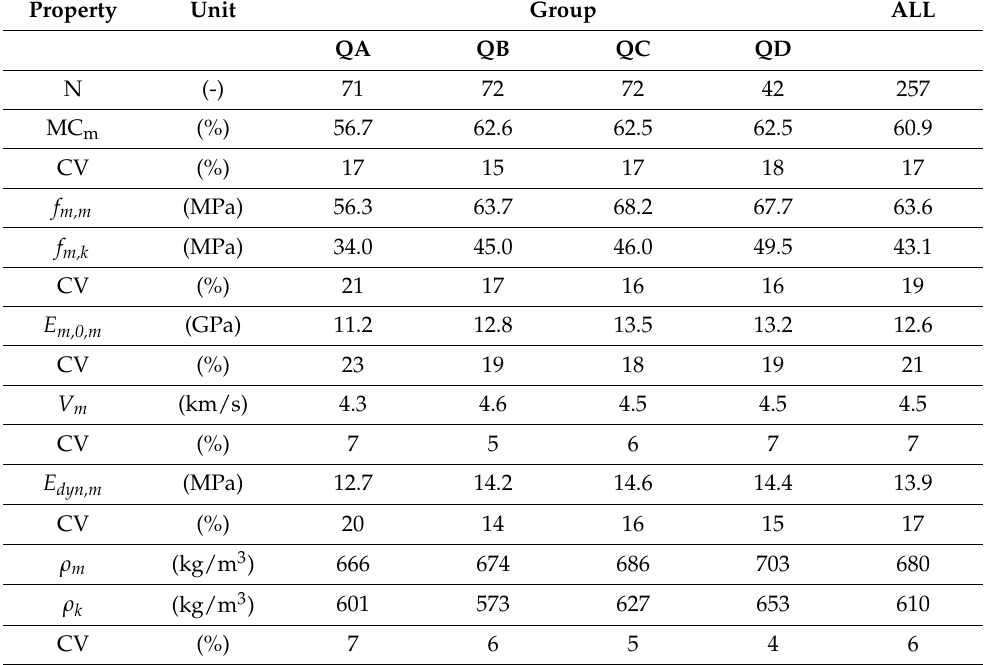
Table 1. Mean values and coefficients of variation (CV) of physical and mechanical properties for the 4 groups of round logs (QA, QB, QC, QD) defined according to the supply over